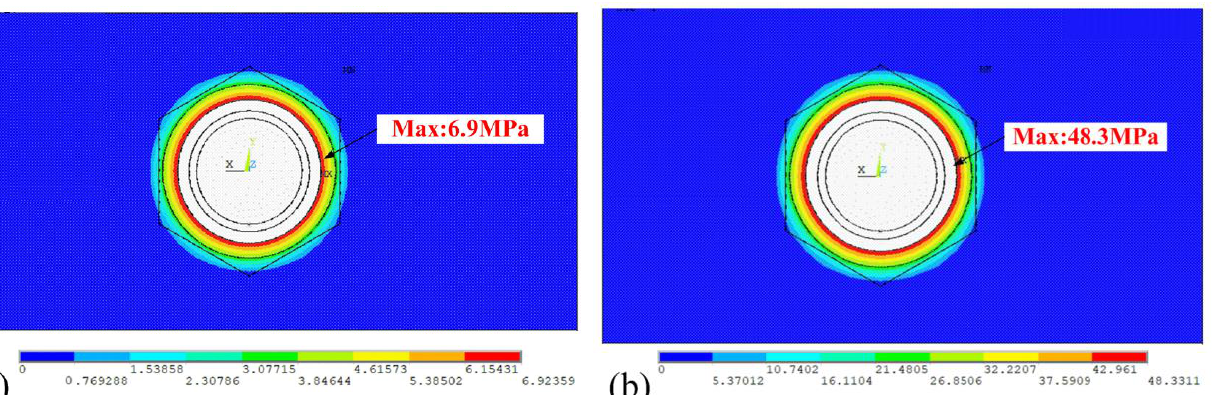
Figure 16. Experimental FRFs influenced by the bolt tension, ( a ) two-beam joint, ( b ) one monolithic beam.